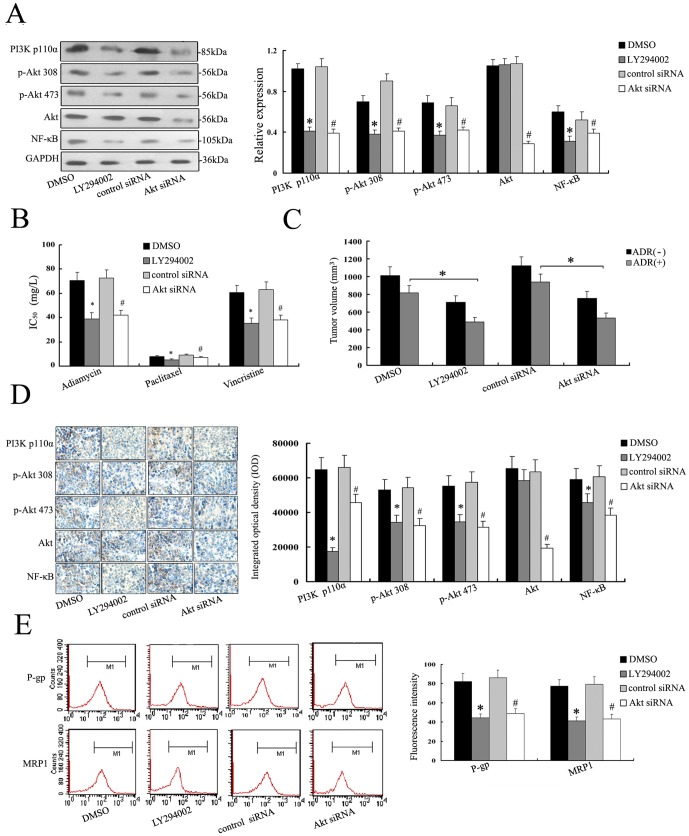
PI3K/Akt inhibition changes the chemosensitivity of K562/ADR cells both in vitro and in vivo.(A) The K562/ADR cells were pretreated LY294002 or Akt siRNA. Expressions of PI3K/Akt signaling molecules were then examined by western blot analysis. LY294002 or Akt siRNA treatment also alleviated chemoresistance of K562/ADR cells, revealed by in vitro (B) and in vivo (C). (D) Down-regulation of PI3K/Akt signaling molecules was also shown by IHC staining in xenograft tumors derived from LY294002 or Akt siRNA treatment cells (400×). (E) Flow cytometry analysis showed that inhibition of PI3K/Akt pathway resulted in reduced levels of P-gp and MRP1. The data are means ± SD of 3 independent assays. *P<0.05 vs DMSO treatment cells; #P<0.05 vs control siRNA treatment cells.